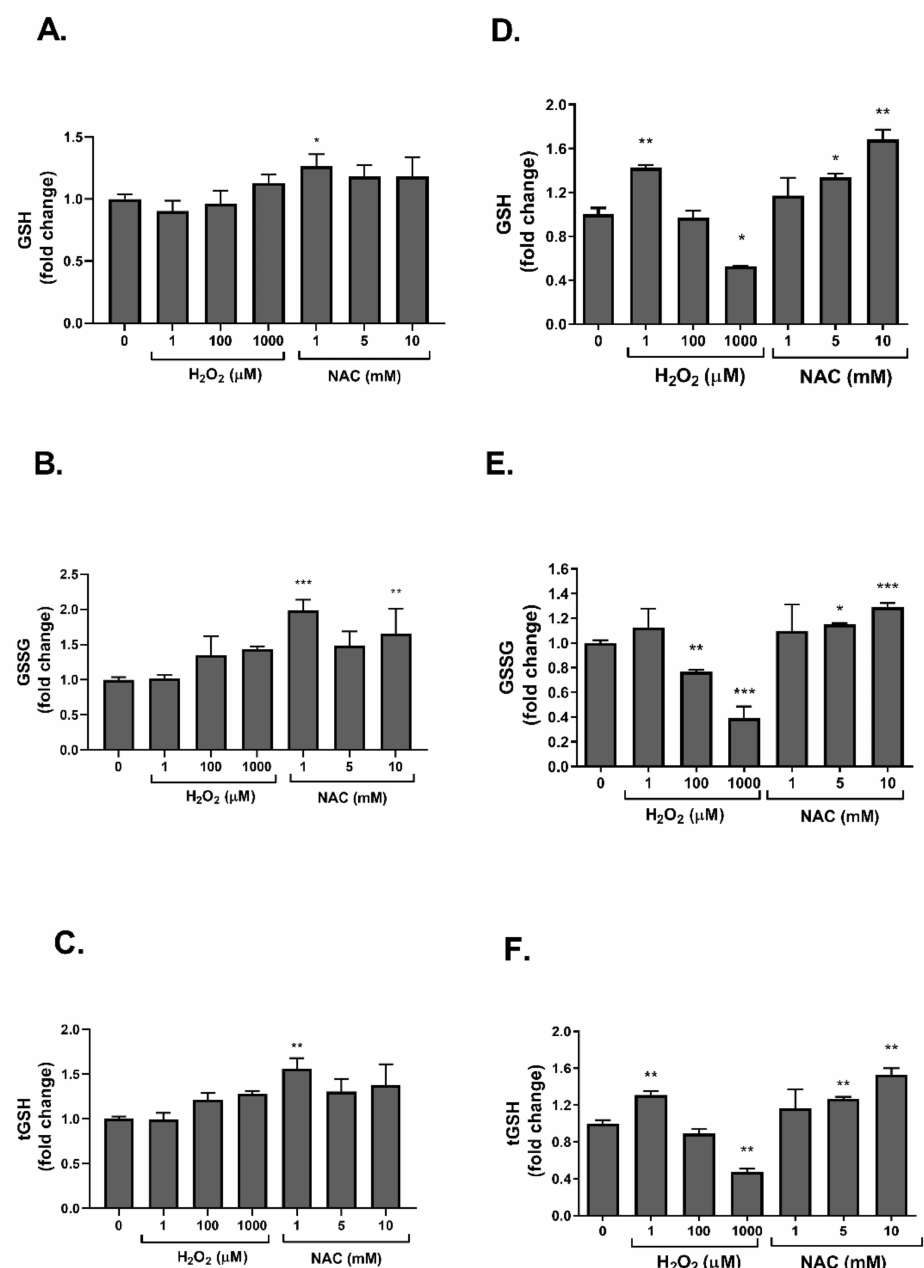
Figure 6. NAC increased glutathione level in 3T3-L1 adipocyte and L6 myotubes. 3T3-L1 ( A – C ) and L6 myotubes ( D – F ) were treated with H 2 O 2 or NAC for 24 h. Levels of GSH, GSSG and total glutathione (tGSH) were measured as described in Methods. The data represent the mean ± SEM of 5 independent experiments. * p < 0.05, ** p < 0.005 and *** p < 0.0005, compared to control, analyzed by one-way ANOVA, followed by Dunnett’s post hoc